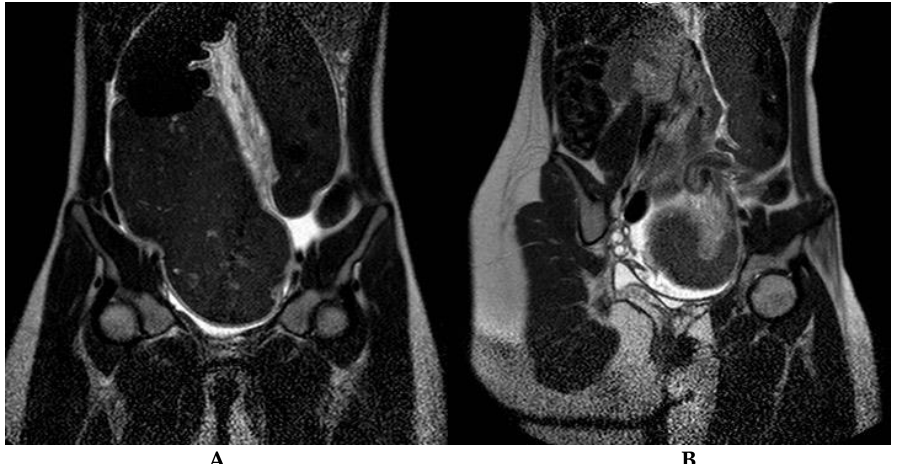
Figure 1. ( A ) Sigmoid colon volvulus in a 14-year-old girl. Fluoroscopic contrast enema shows visceral twisting of the distal sigmoid and gas-filled upstream bowel loops. ( B ) Transverse colon volvulus in a 13-year-old girl. Fluoroscopic contrast enema demonstrates visceral twisting of the transverse colon.